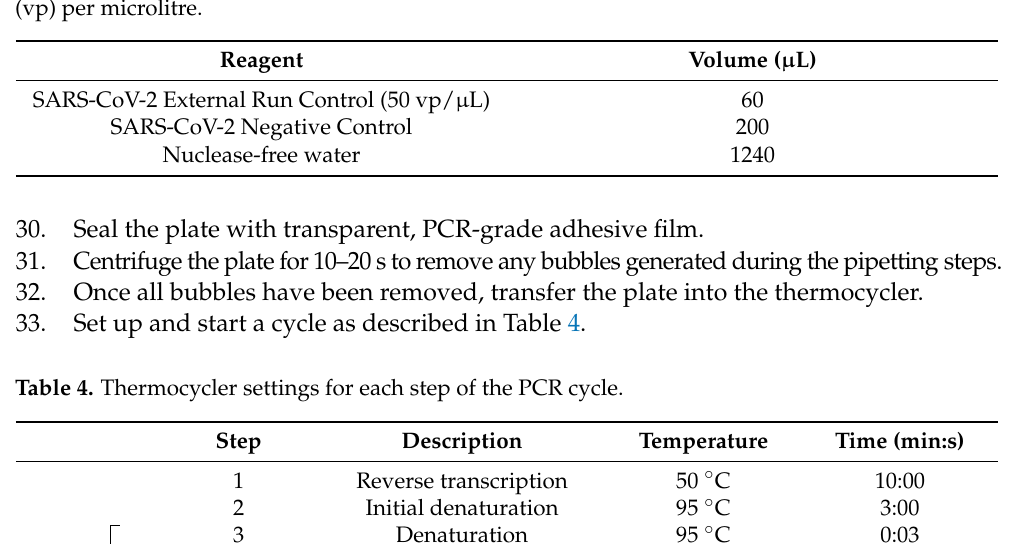
Table 3. Reagents required for a 1.5 mL working stock of positive control containing 2 viral particles (vp) per microlitre.